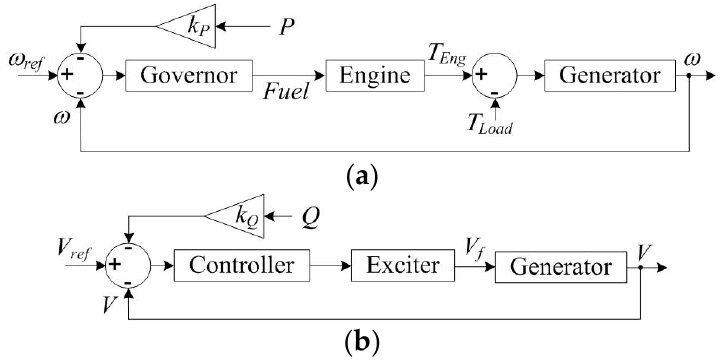
Figure 5. Engine-generator control system ( a ) speed droop and ( b ) voltage droop.